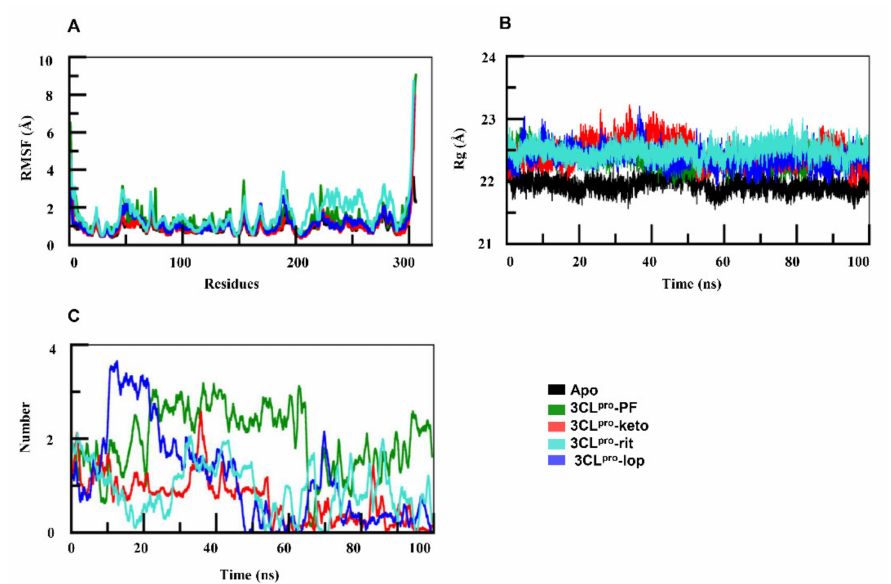
Figure 3. ( A ) Root mean square fluctuation graphs of apo-3CL pro and of 3CL pro complexes. In comparison with the apo-form, regions spanning amino acid residues 45–75 and 150–200 in both docked complexes showed deviations. ( B ) Radius of gyration of the 3CL pro in complexes was higher than that of its apo-form. ( C ) Number of hydrogen bonds in the four complexes.